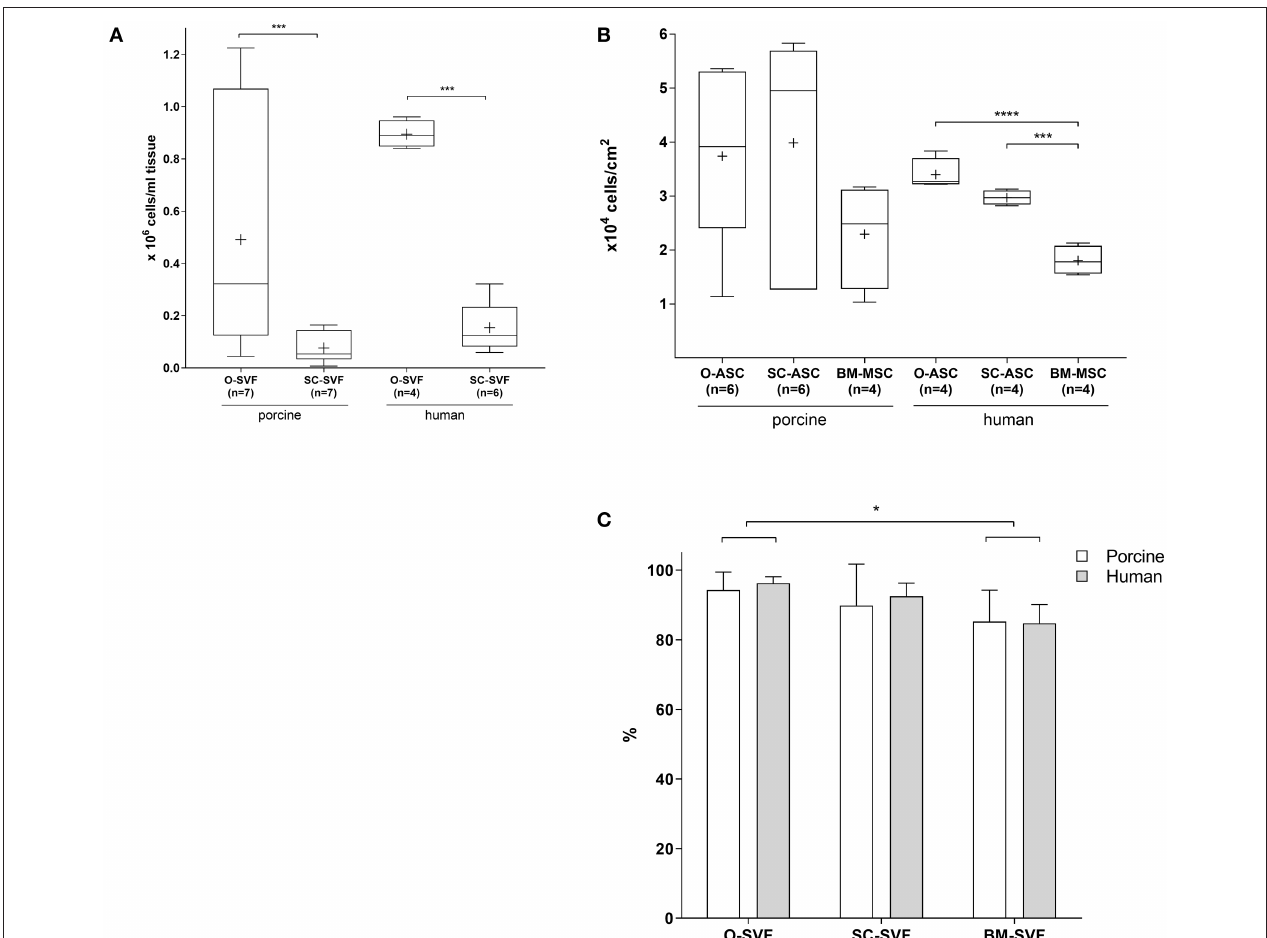
FIGURE 1 | Cell isolation. (A) Cell yields after isolation following specific protocols for each cell type. The resulting cell population after isolation is the so called ≪ stromal vascular fraction ≫ (SVF). BM-MSC are not displayed since no precise tissue amount could be determined due to flushing. Expressed in number of cells per mL of harvested tissue. Cross = mean, whiskers = 5–95 percentile. (B) Cell yields after first passaging of plated cells at a density of 10,000 cells/cm 2 , passaged at 80–90% confluency. Expressed in number of cells per cm 2 . Cross = mean, whiskers = 5–95 percentile. (C) Viability of freshly isolated cells as determined by Tryptan blue exclusion. Expressed in viable cell % of total cells. Error bars = SD. Unpaired t -test. * p < 0.05, *** p < 0.001, **** p < 0.0001.